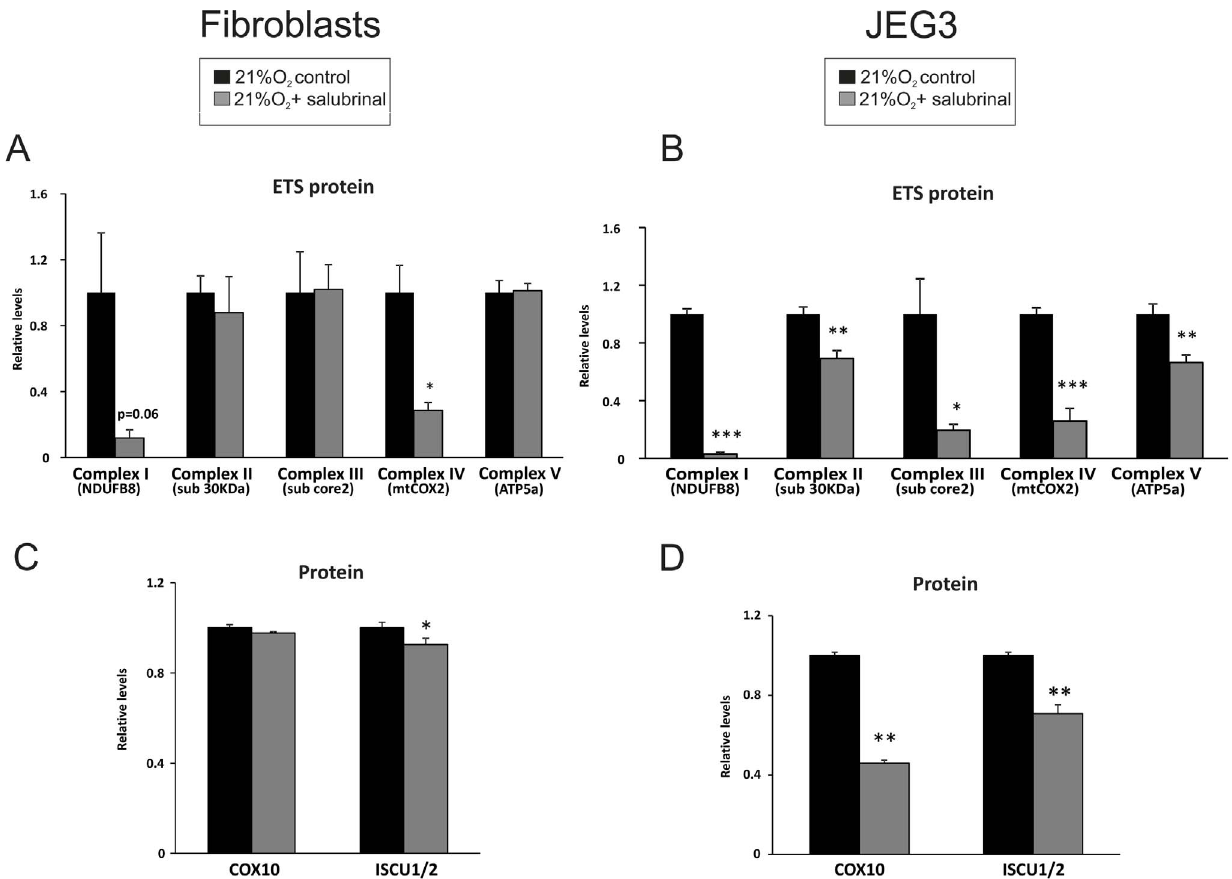
Figure 4. Sublethal dosage of salubrinal downregulates ETS, COX10 and ISCU1/2 protein levels in fibroblasts and JEG3 cells. A, B) Protein levels of ETS complexes I-IV and V (ATP-synthase) in A) fibroblasts and B) JEG3. C, D) Protein levels of COX10 and ISCU1/2 in C) fibroblasts and in D) JEG3. * p , 0.05, ** p , 0.01, *** p , 0.001 compared with cells cultured without salubrinal. Minimum of three biological replicates per cell type for each condition were performed.